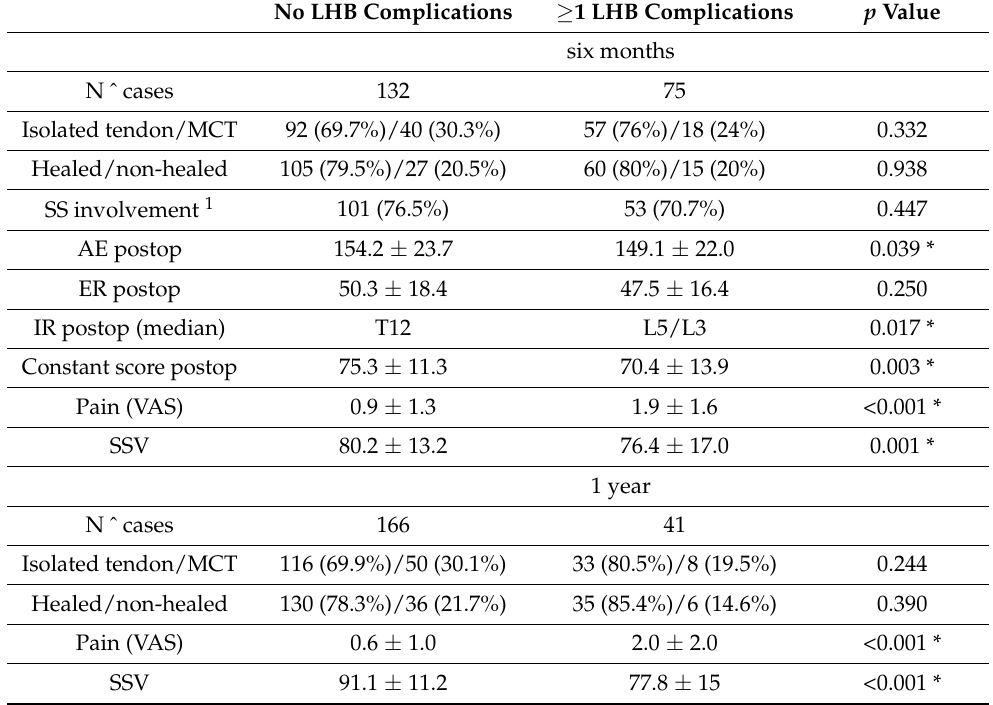
Table 4. Comparison of patients with and without